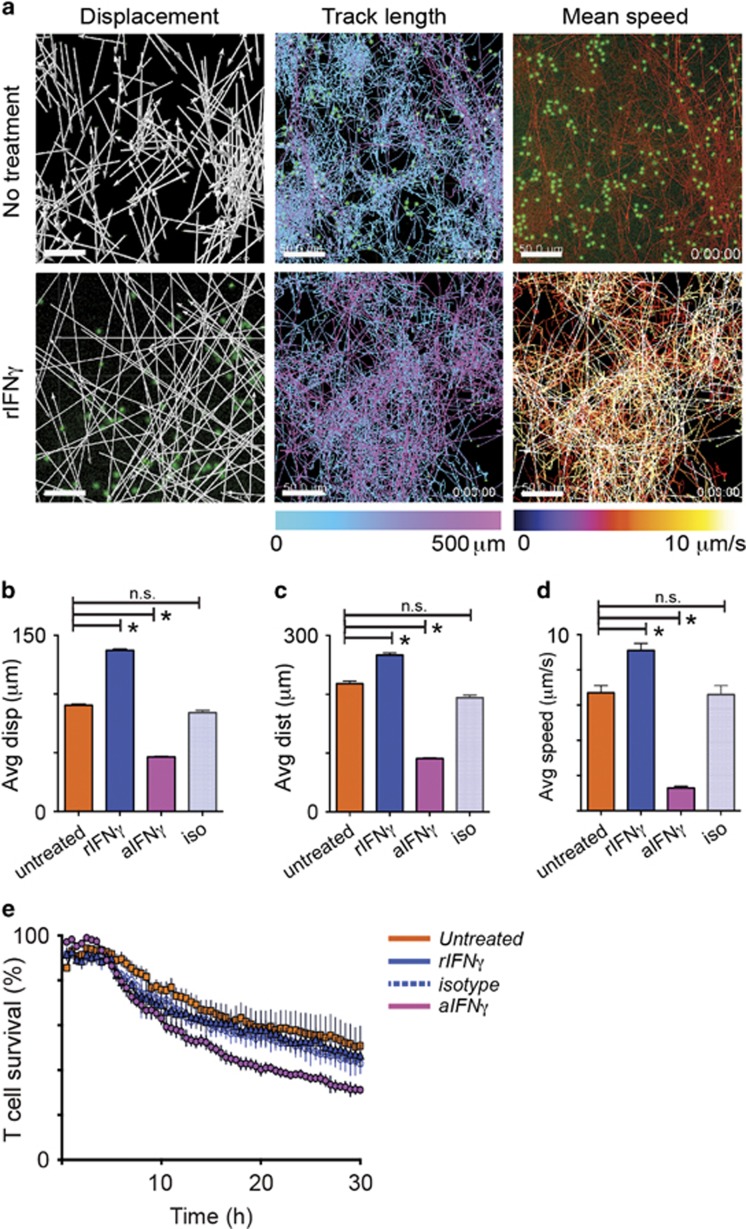
Suppression of autocrine signaling of IFNγ on CTL inhibits their cytotoxicity and motility. IFNγ−/− CTL cells or EGFP+OT-I CTL pre-treated with PBS, rIFNγ or anti-IFNγ for 4 h, were co-cultured with SIINFEKL-loaded target KC. The kinematics of CTL were analyzed using fluorescence time-lapse movies of 30 h as above. (a) Examples of images of tracked CD8 T cells. Displacement is shown in white arrows, and track length and mean speed are shown in color. Scale bars, 50 μm. (b–d) Pre-treated B6 CTL or IFNγ−/− CTL in co-culture with targets for 30 h were investigated for vectorial displacement, distance traveled, and mean speed. Data are pooled results of 3 independent experiments (around 200 cells). Error bars are SEM. (*P<0.05, n.s. not significant) (e) Rate of death of pre-treated CD8 T cells during co-culture with target cells. The number of surviving T cells was determined by software, expressing the number of green cells (size >7 μm) at each frame as a percentage of the number of cells at the start. N=3. Error bars are s.e.m.